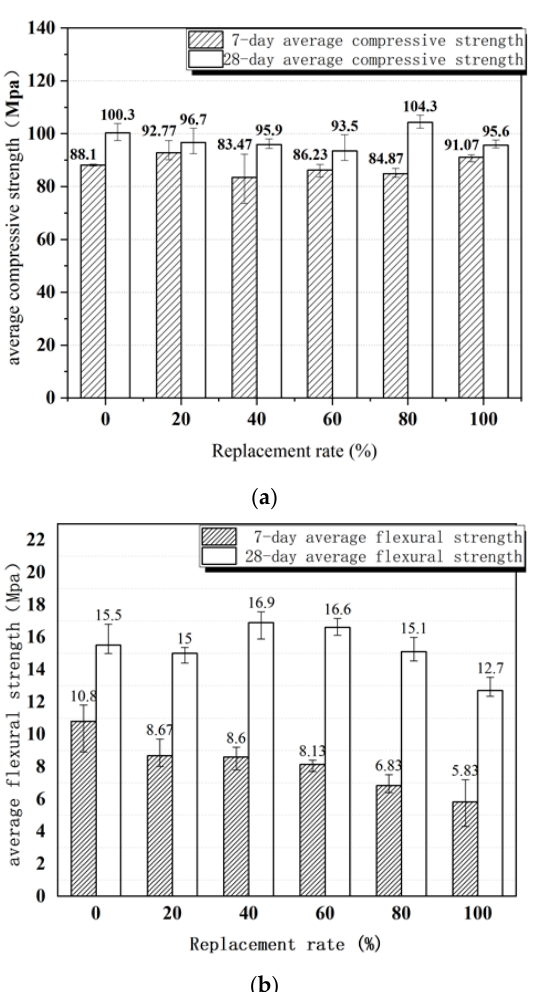
Figure 12. Mechanical properties of high-strength concrete: ( a ) compressive strength; ( b ) flexural strength.